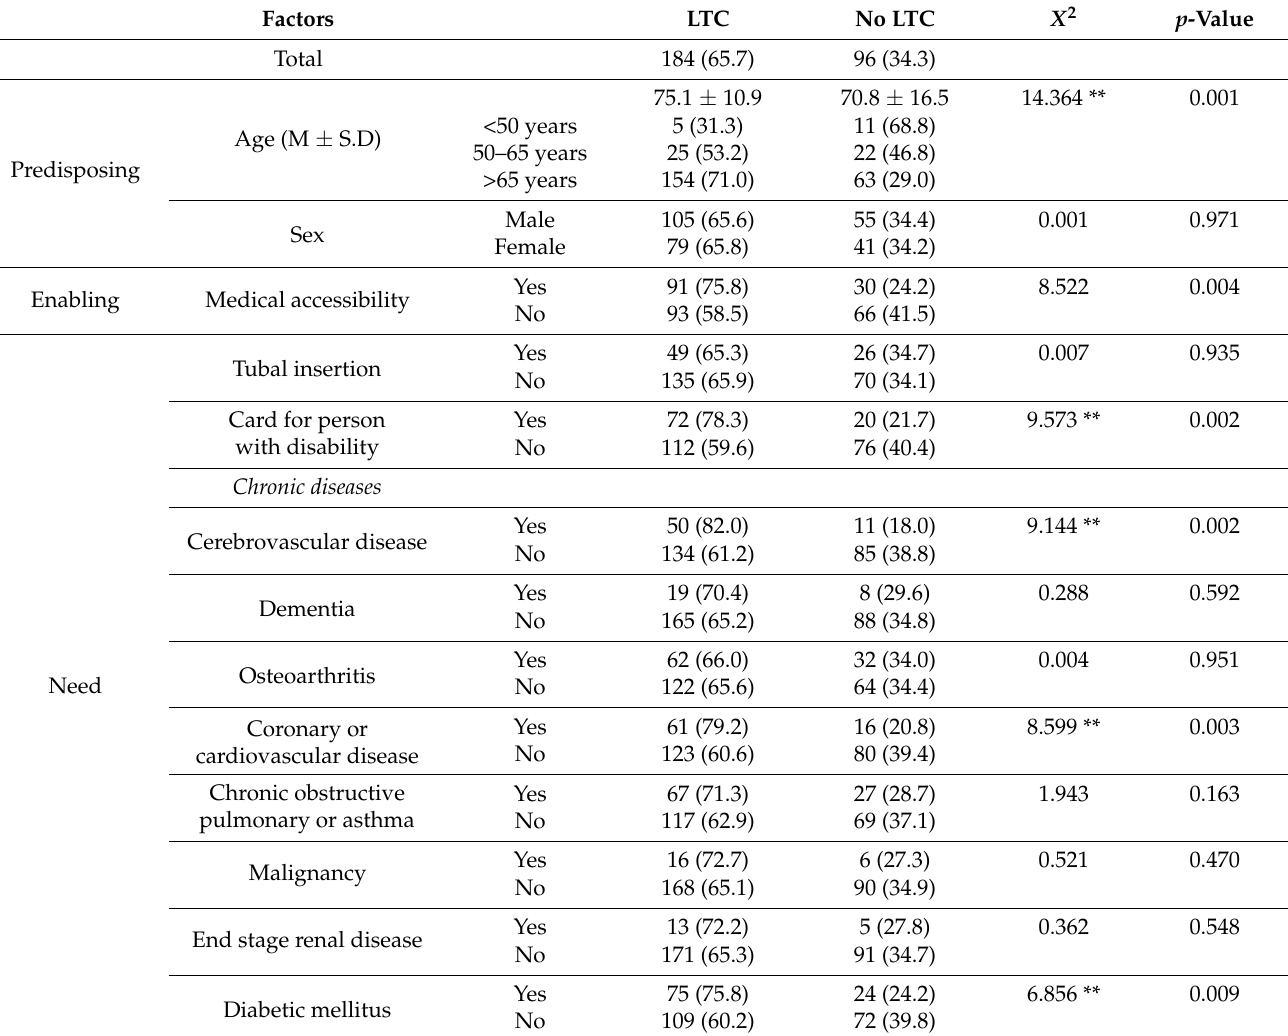
Table 2. Characteristics of patients by utilization of long-term care 2.0 (N =